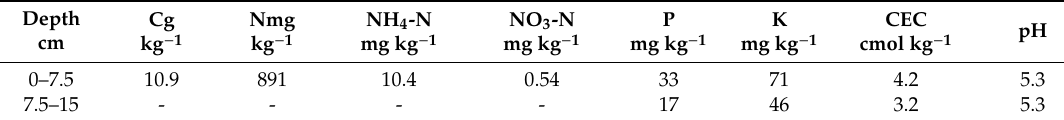
Table 1. Chemical properties of the Norfolk loamy sand